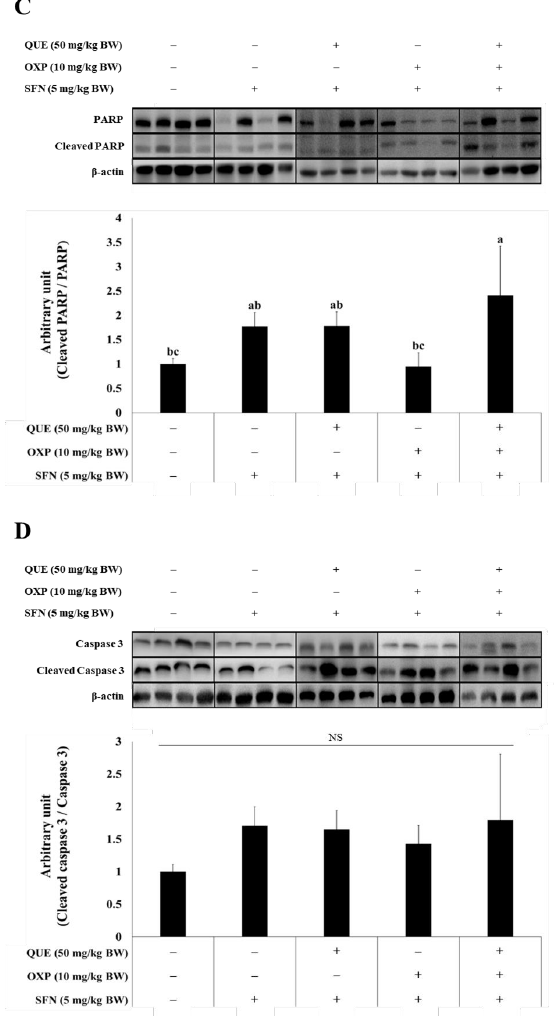
Figure 8. A combination of QUE, SFN, and OXP increased the protein expressions of apoptotic markers in HCT116 xenograft tumor. The levels of pro-apoptotic proteins, including Bax/Bcl-2, cy- tochrome C, cleaved PARP, and cleaved caspase 3, were increased in the xenograft tumors from the mice given QUE in combination with OXP. Western blot images exhibit the expression levels of Bax/Bcl-2 ( A ), cytochrome C ( B ), cleaved PARP/full-length PARP ( C ), and cleaved caspase 3/caspase 3 ( D ). β-actin was used as a loading control to ensure consistency. The quantitative graphs were constructed with data from four independent tumor samples from each treatment group. Error bars represent mean ± SD ( n = 4). Different alphabetical letters indicate significant differences among the conditions ( p < 0.05, one-way ANOVA with Duncan’s post hoc HSD test). NS, no statistical signifi- cance.